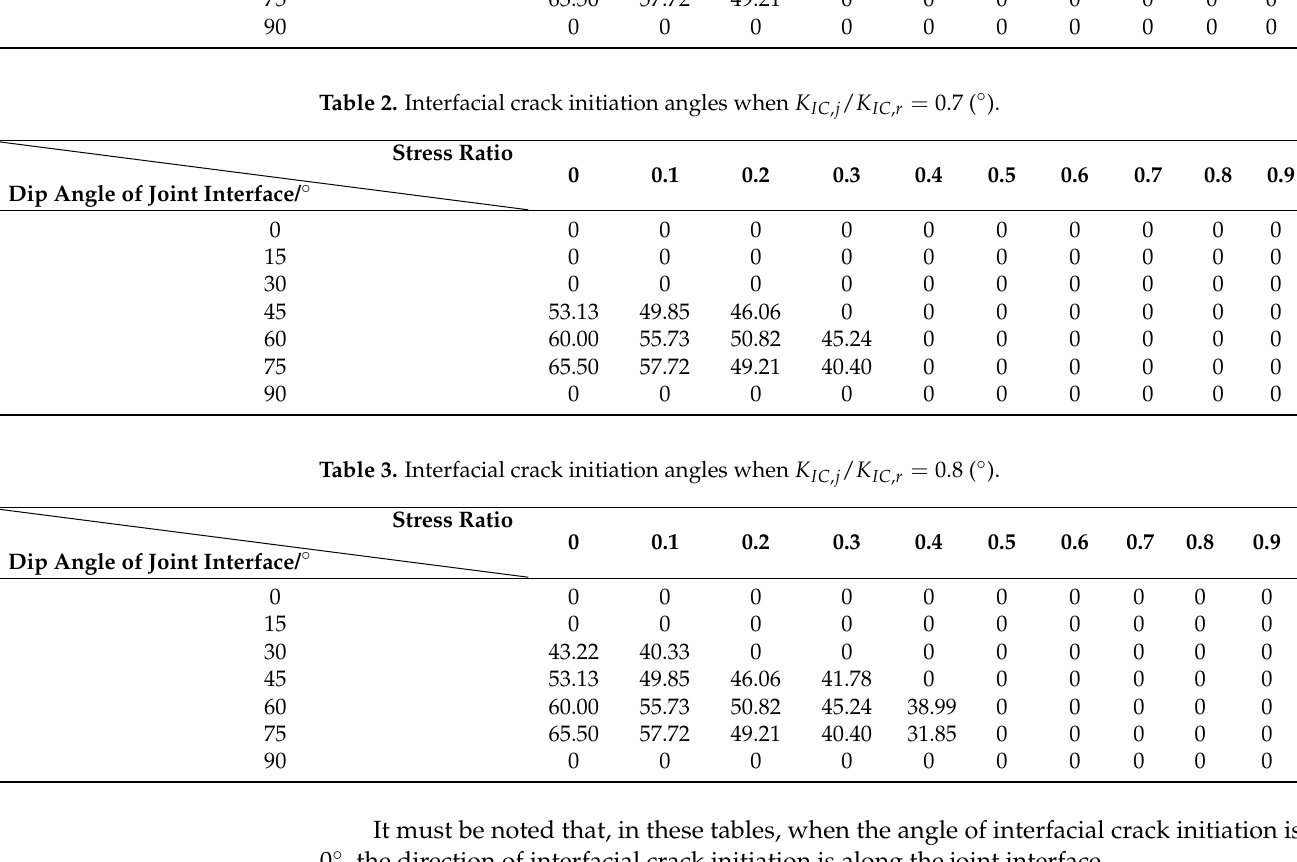
Table 2. Interfacial crack initiation angles when K IC , j / K IC , r = 0.7 ( ◦ ).